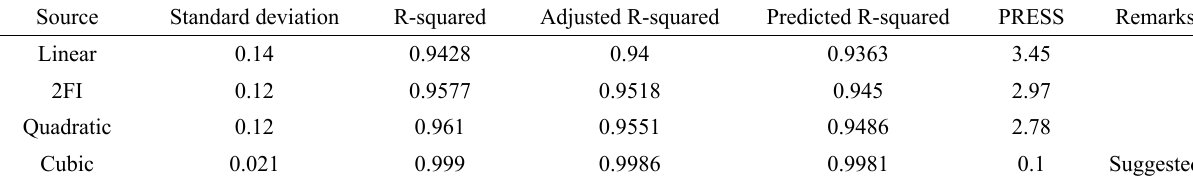
Table 5 R-Squared values for different models in case of wear rate.